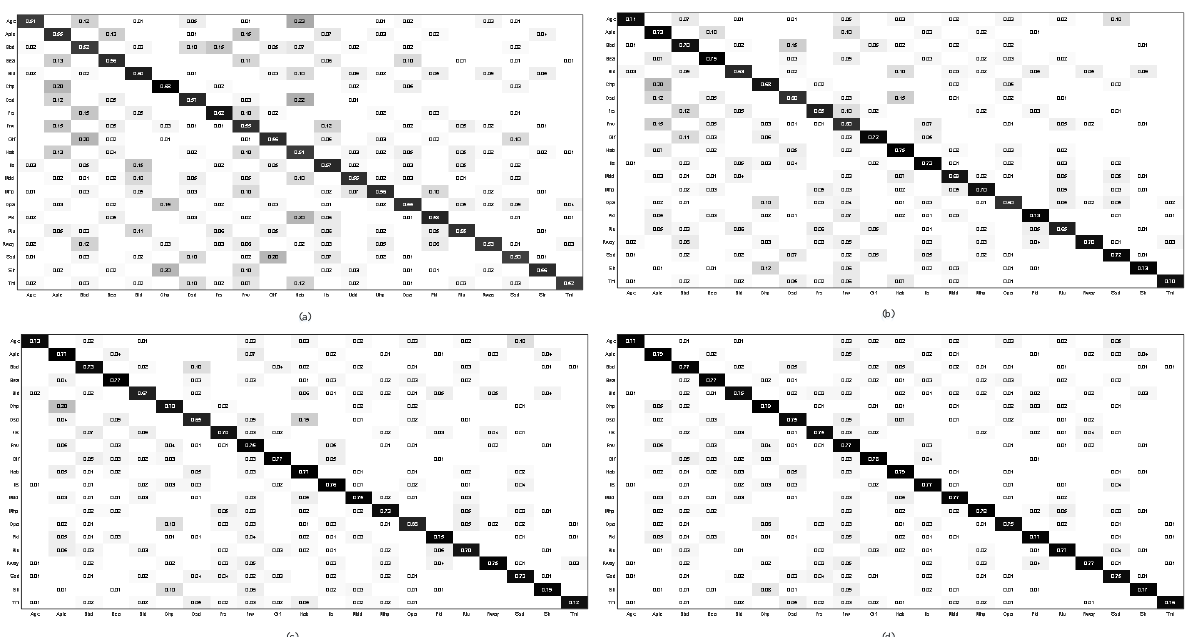
Figure 7. The confusion matrix of 30 sample training sets of UC Merced data set, ( a ) MARTA-GAN; ( b ) sifting GAN; ( c ) SPG-GAN; ( d ) proposed.